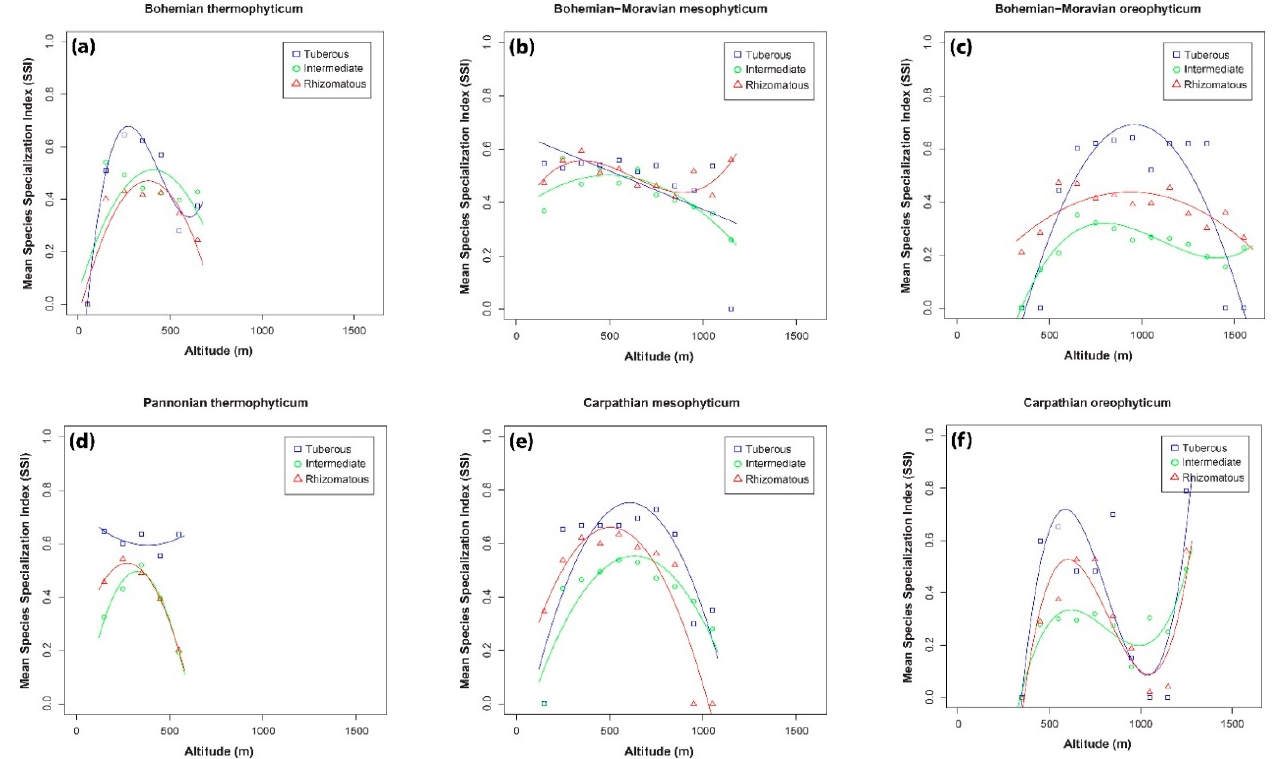
Figure 5. Relationships between mean species specialization index ( SSI ) and altitude recorded for the three orchid groups in the phytogeographical area of: ( a ) Bohemian thermophyticum, ( b ) Bohemian-Moravian mesophyticum, ( c ) Bohemian- Moravian oreophyticum, ( d ) Pannonian thermophyticum, ( e ) Carpathian mesophyticum and ( f ) Carpathian oreophyti- cum.